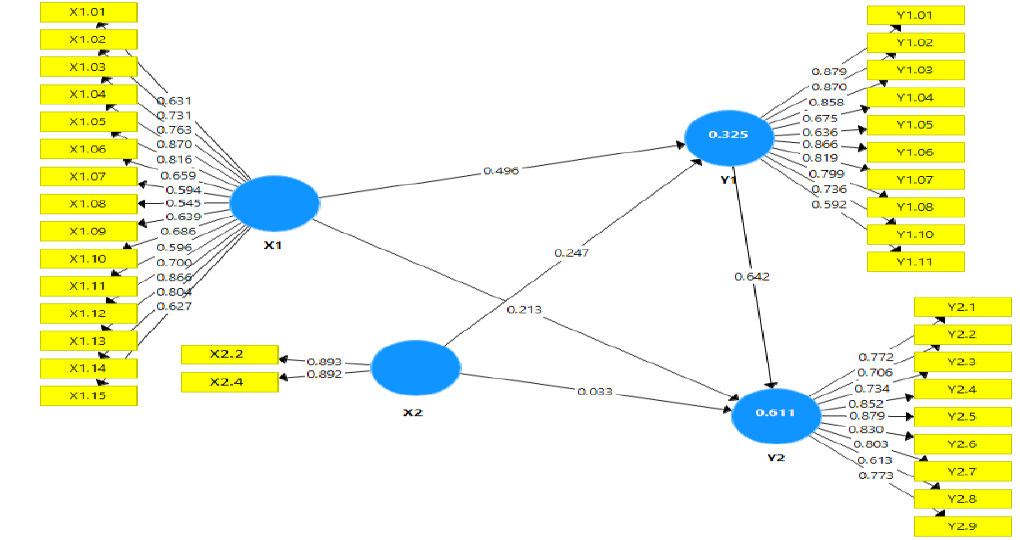
Figure 2: Diagram of Hypothesis Testing Results Using